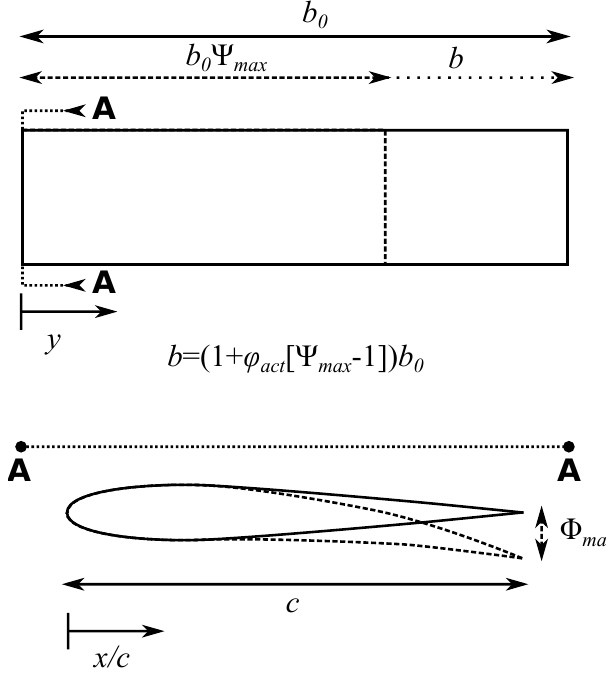
Figure 6. Schematic of the wing, including wing